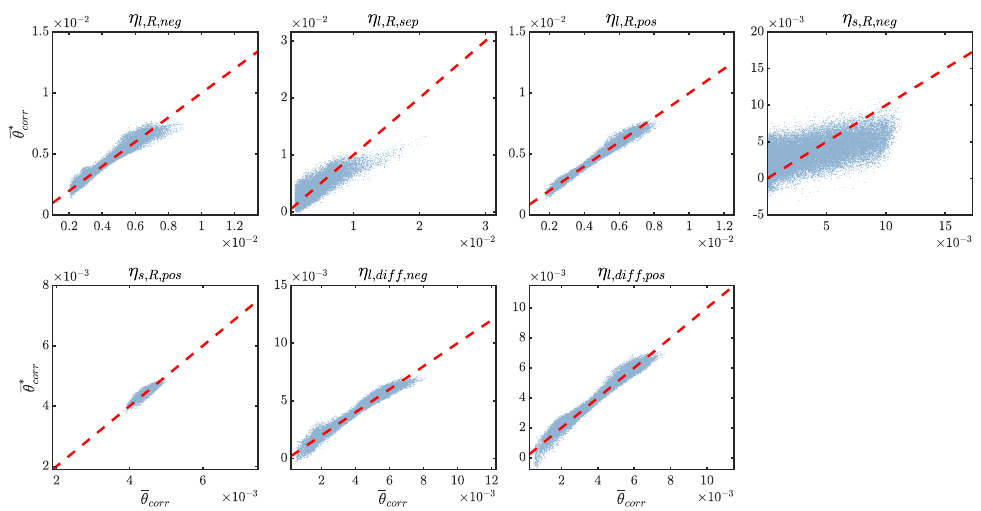
Figure 8. Results of parameter correlation for case 3. A correlation relation can be observed for each process except for the solid conduction in the anode.